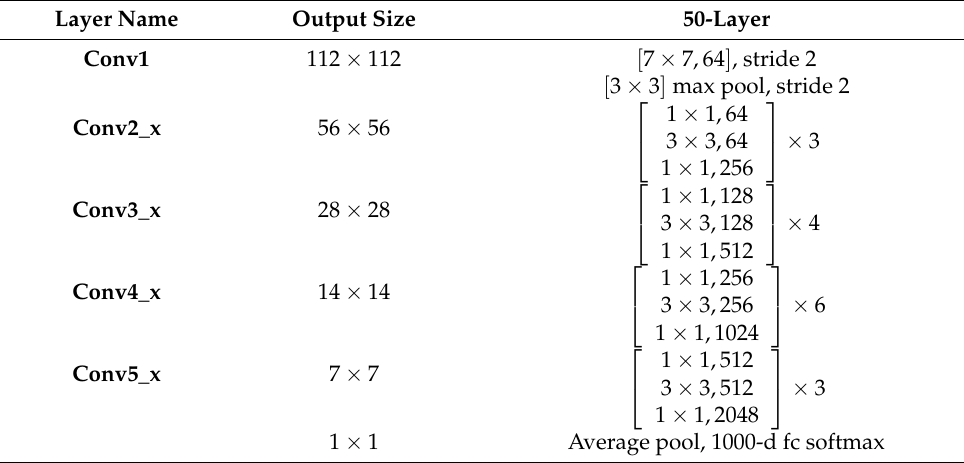
Figure 1. Residual learning module of ResNet.